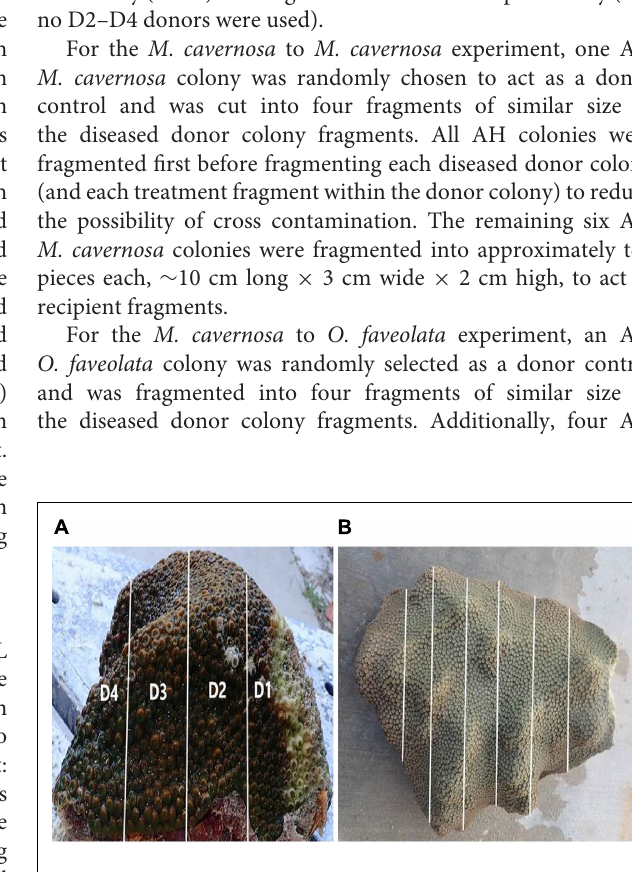
Frontiers in Marine Science |